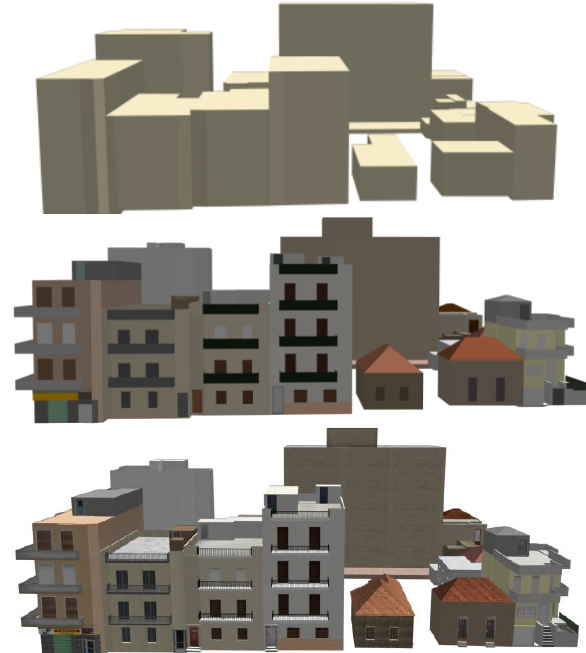
Figure 6. 3D views of the building models of an urban block at LoD1 (top), LoD2 (middle) and LoD3 (bottom)